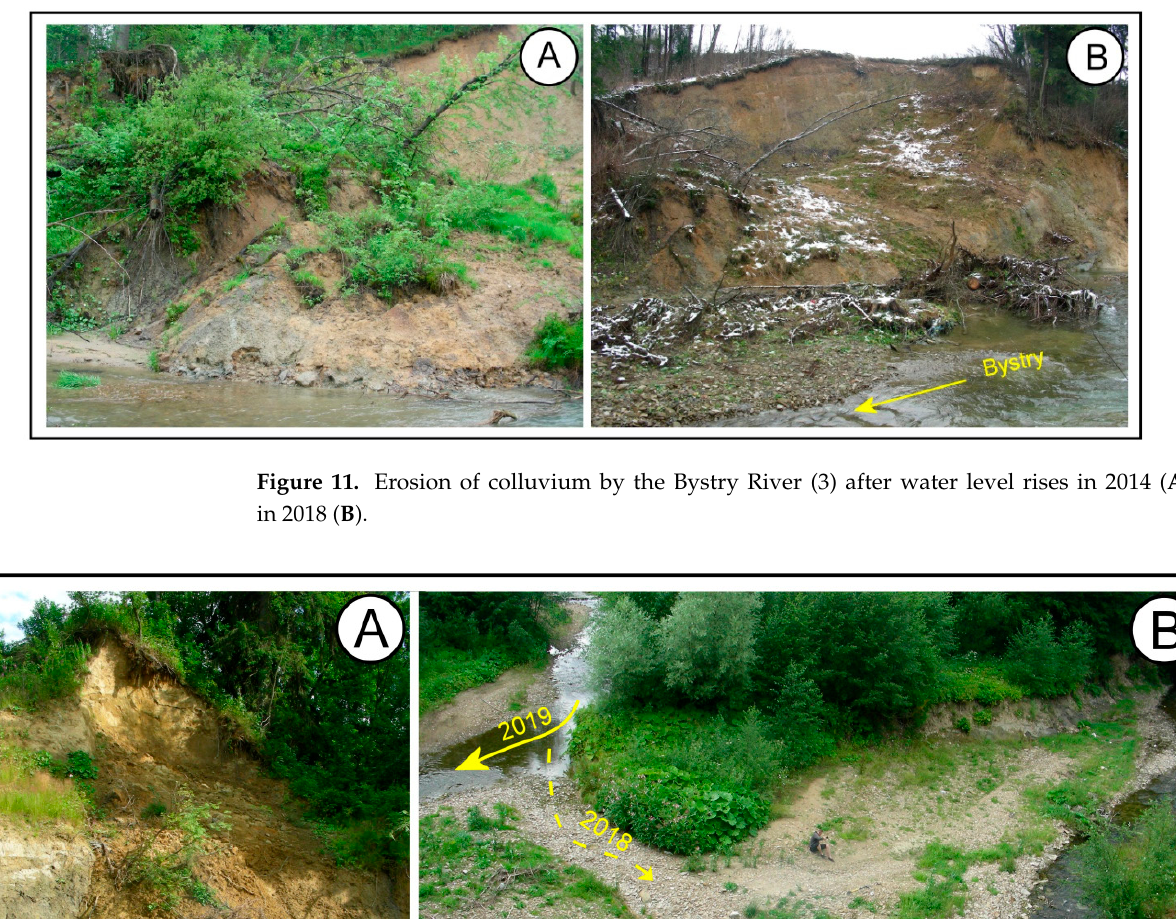
Figure 10. Transformation of the C-RCZ at site 3 in years 2013–2019; ( A )—plan of the landslide and river channel in 2019; ( B )—stages of landslide reactivation: 1—landslide main scarp, 2—erosional undercutting of the channel bank, 3—colluvial tongue, 4—river channel, 5—lateral gravel bar, 6— sections of the C-RCZ; 7—landslide surface in 2013, 8—surface of landslide rejuvenation in 2019,